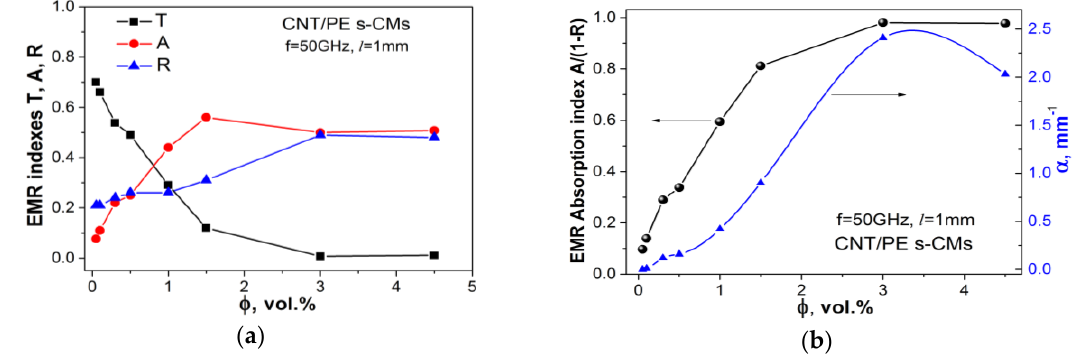
Figure 7. EMR reflection R , absorption A , transmission T ( a ) and EMR absorption indices A ef f , α ( b ) for CNT / PEs-CMs versus filler content at the fixed frequency 50 GHz. Samples’ thickness is 1